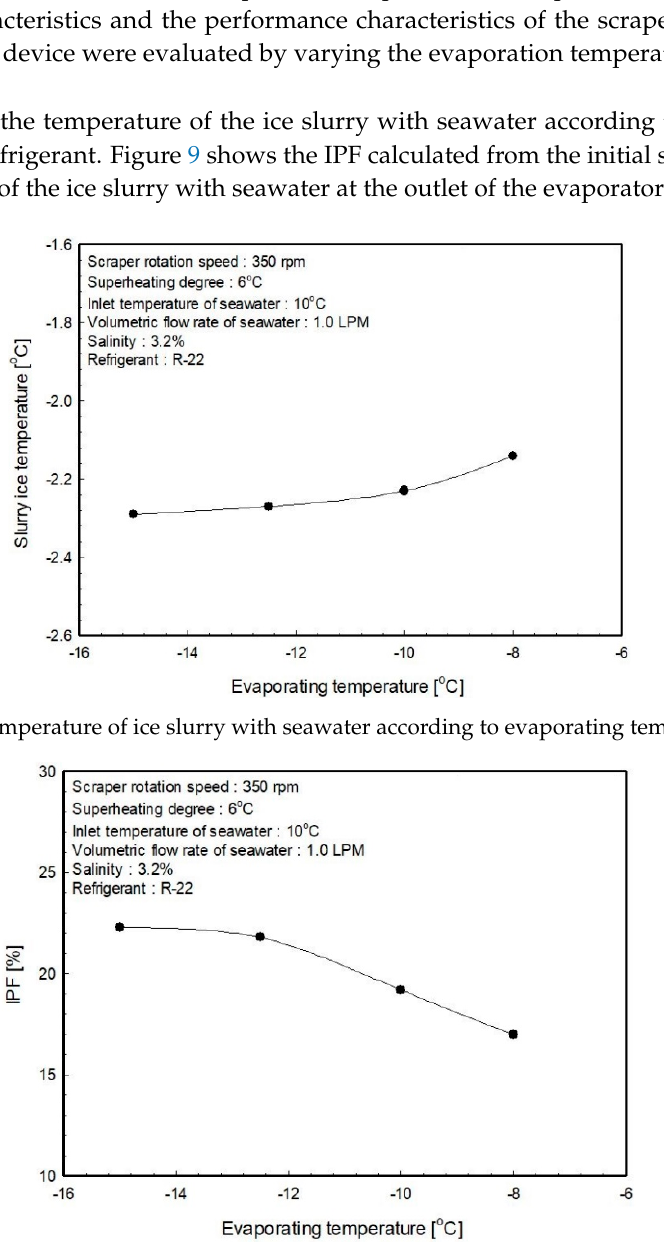
Figure 9. IPF with respect to evaporating temperature.